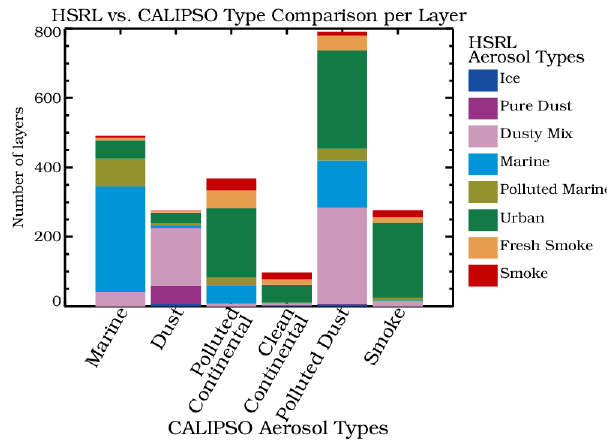
Fig. 2. Histogram showing the results of matching up HSRL-1 and CALIOP layer-by-layer for coincident flights, using CALIOP layer detection. The x-axis shows the six CALIOP types and the colors indicate the HSRL